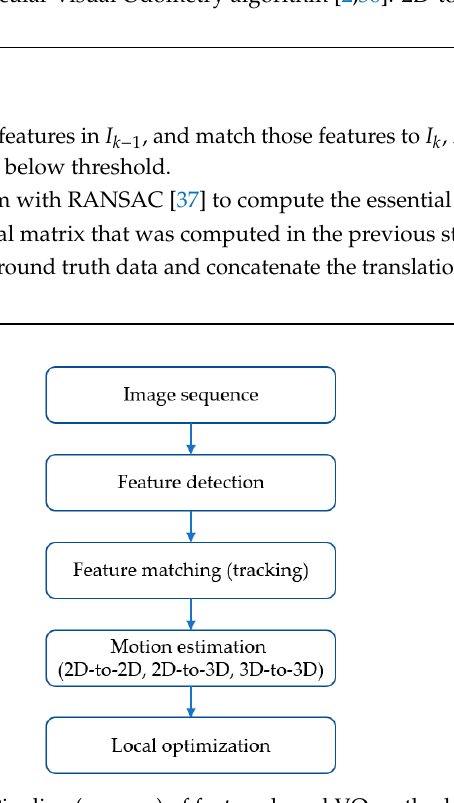
Figure 2. Pipeline (process) of feature-based VO method [2]. Algorithm 1 Pseudo-code of Monocular Visual Odometry algorithm [2,36]. 2D-to-2D Monocular Visual Odometry